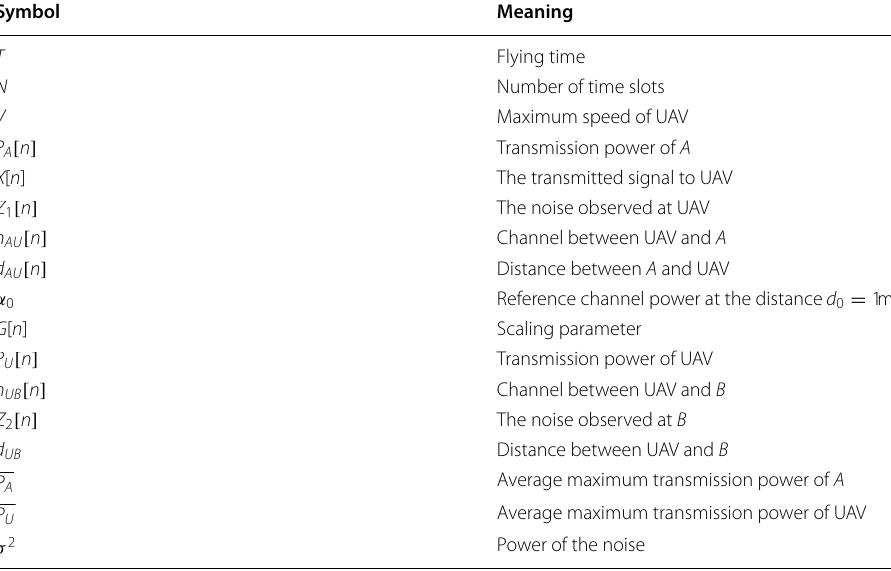
Table 1 Definitions of a subset of commonly used symbols